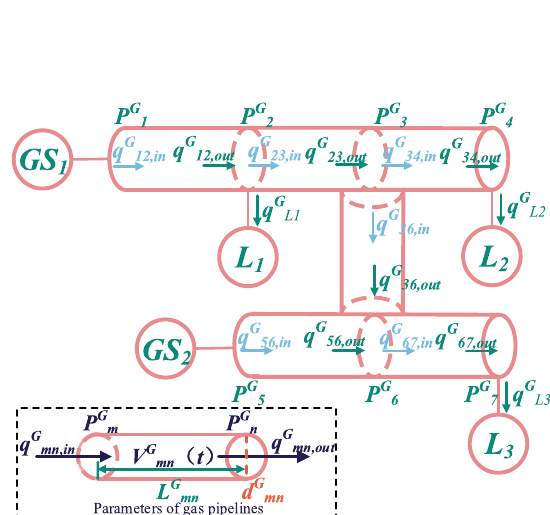
Fig. 2 The 8-node gas network structure diagram and relevant parameters of gas